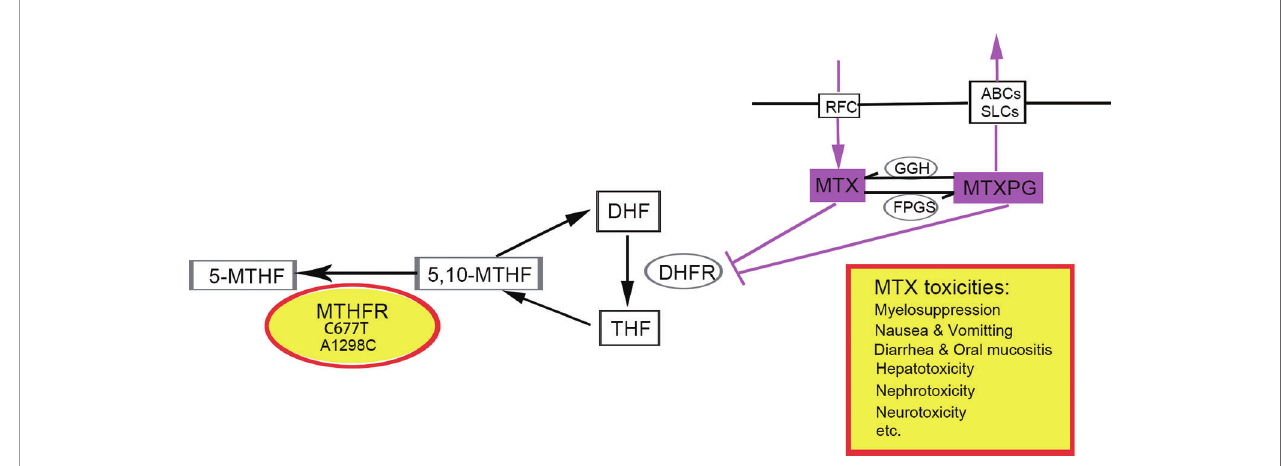
FIGURE 1 | The role of MTHFR polymorphism in folate cycle and MTX metabolism. Polymorphisms in gene MTHFR could reduce the enzyme activity, leading to increased availability of 5,10-MTHF and decreased 5-MTHF. Consequently, the impaired conversion of 5, 10-MTHF to 5-MTHF could modify folate pools and in turn, alter the response of malignant and nonmalignant cells to MTX and potentially aggravates its toxicity. 5-MTHF, 5-methyltetrahydrofolate; 5,10-MTHF, 5,10- methylenetetrahydrofolate; DHF, dihydrofolate; THF, tetrahydrofolate; MTX, methotrexate; MTXPG, methotrexate polyglutamated forms. Transporters, RFC, reduced folate carrier; ABCs, ABC family transporters; SLCs, SLC family transporters. Enzymes, MTHFR, methylenetetrahydrofolate reductase; DHFR, dihydrofolate reductase; GGH, c-glutamyl hydrolase; FPGS, folylpolyglutamyl